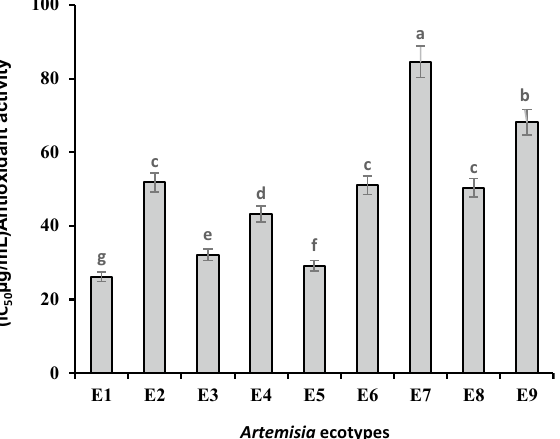
Figure 5. Comparison of mean ± standard error of antioxidant activity of Artemisia ecotypes by DPPH method. E1: A.tournefortiana (Kerman province), E2: A.tournefortiana (North Khorasan province), E3: A.tournefortiana (West Azerbaijan province), E4: A.khorassanica (South Khorasan province), E5: A.khorassanica (North Khorasan province), E6: A.khorassanica (Semnan province), E7: A.haussknechtii (Kohgiluyeh and Boyer-Ahmad province), E8: A.haussknechtii (Isfahan province), E9: A.haussknechtii (Chaharmahal and Bakhtiari province).